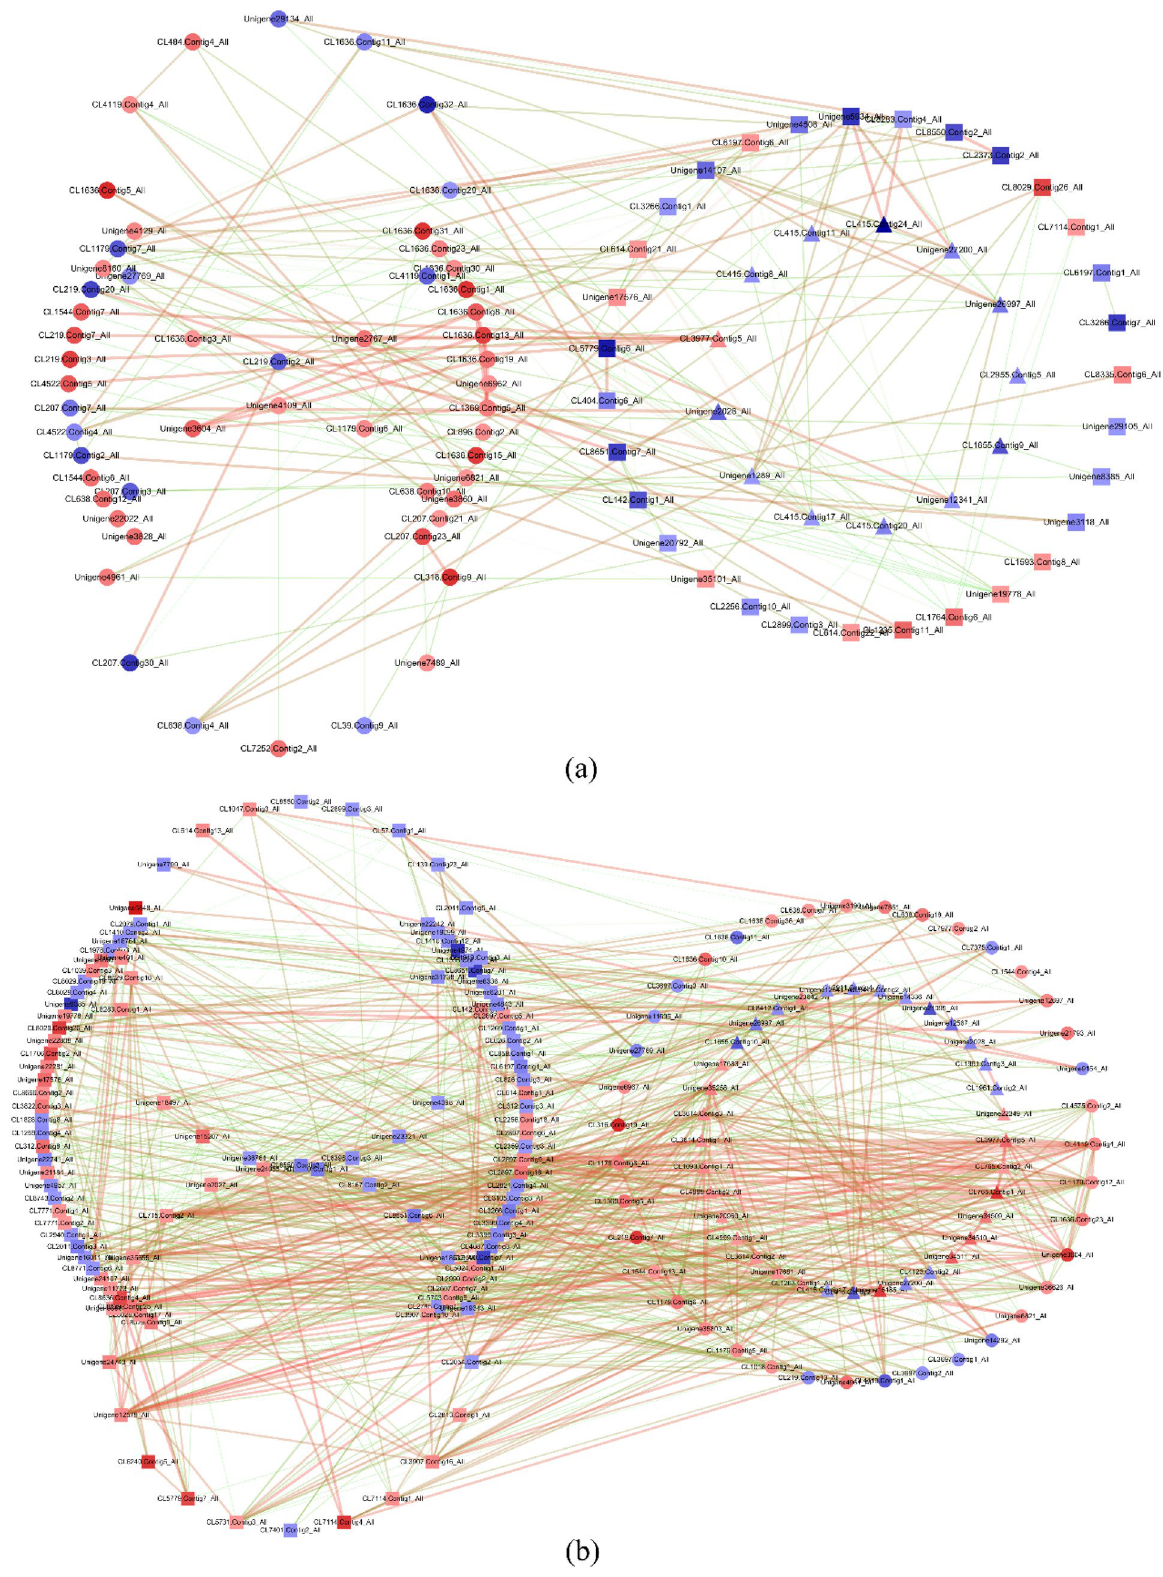
Figure 4. Gene co-expression networks of nitrogen metabolism, circadian rhythms, and hormone signal transduction pathways in the root system of walnut seedlings under nitrogen starvation ( a ) and excess ( b ). ○ represents genes related to circadian rhythms, △ represents genes related to nitrogen metabolism, and □ represents genes related to plant hormone signal transduction. The colour gradient of connections, from green to red, indicates a Pearson correlation coefficient from −1 to 1; a darker colour and a thicker connection indicate a higher correlation. The colour gradient of dots, from blue to red, indicates a log 2 (fold change) from negative to positive, and a darker colour indicates a greater absolute value of log 2 (fold